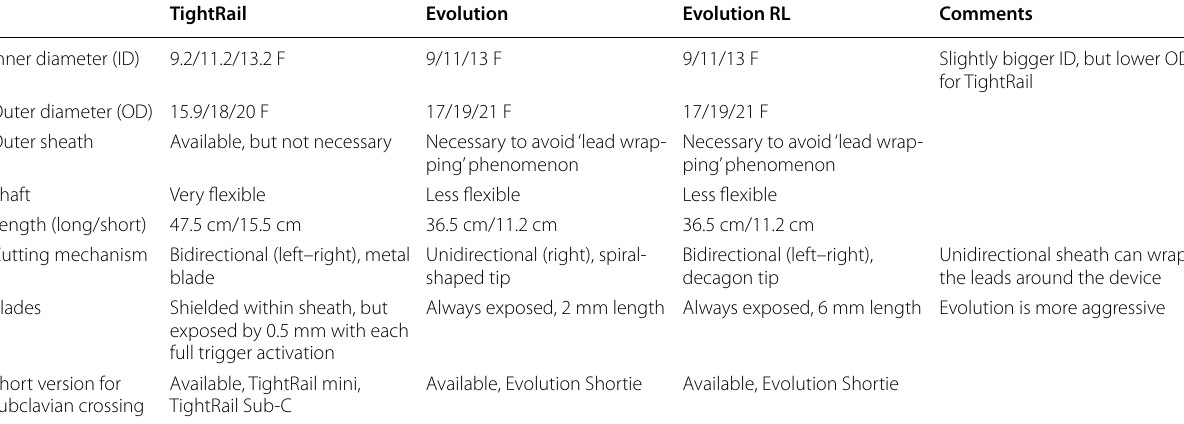
Table 1 Comparison of various rotational mechanical dilator